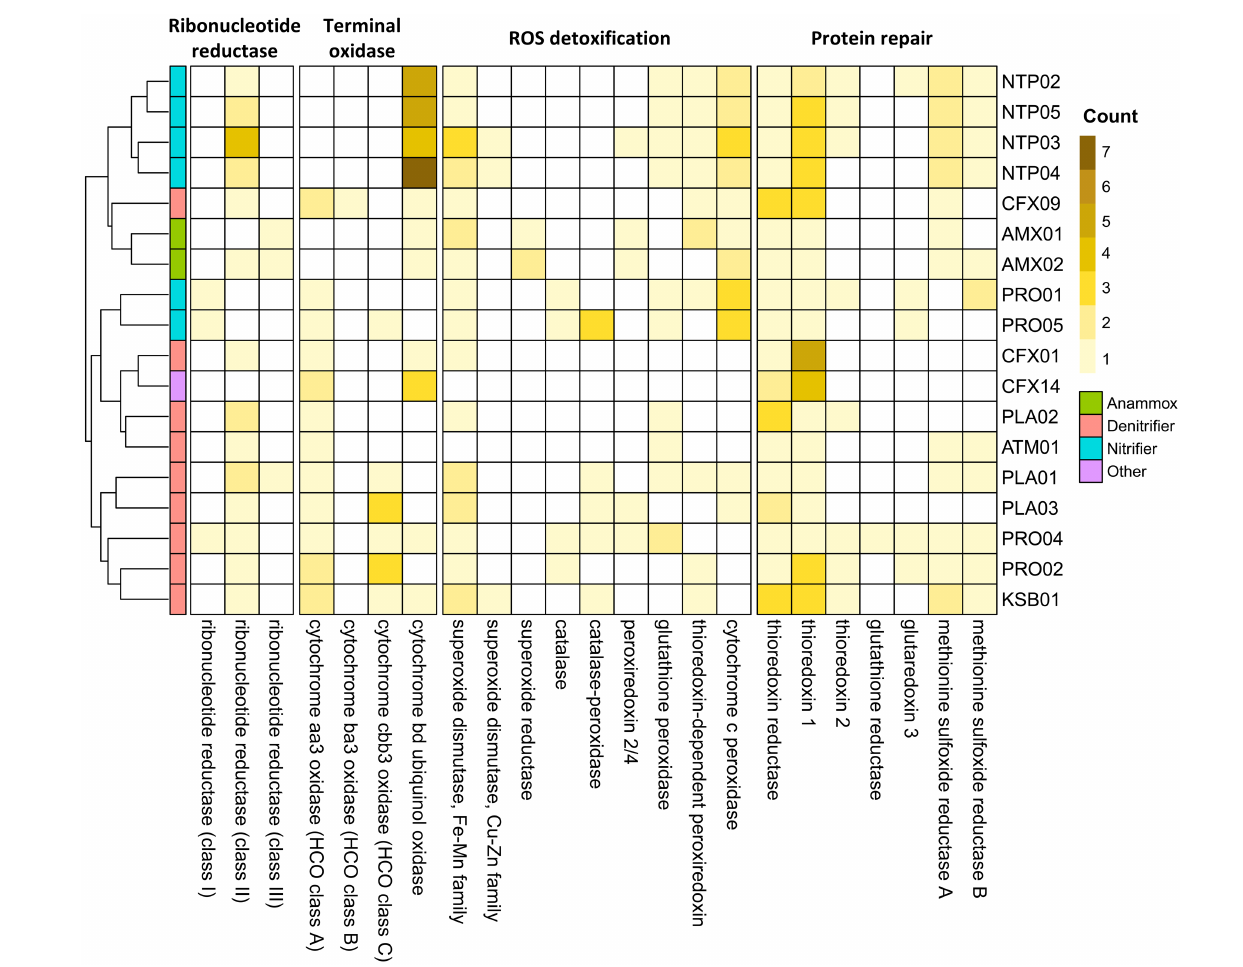
FIGURE 4 Distribution of genes encoding ribonucleotide reductases, terminal oxidases and ROS defense enzymes detected in the 18 core